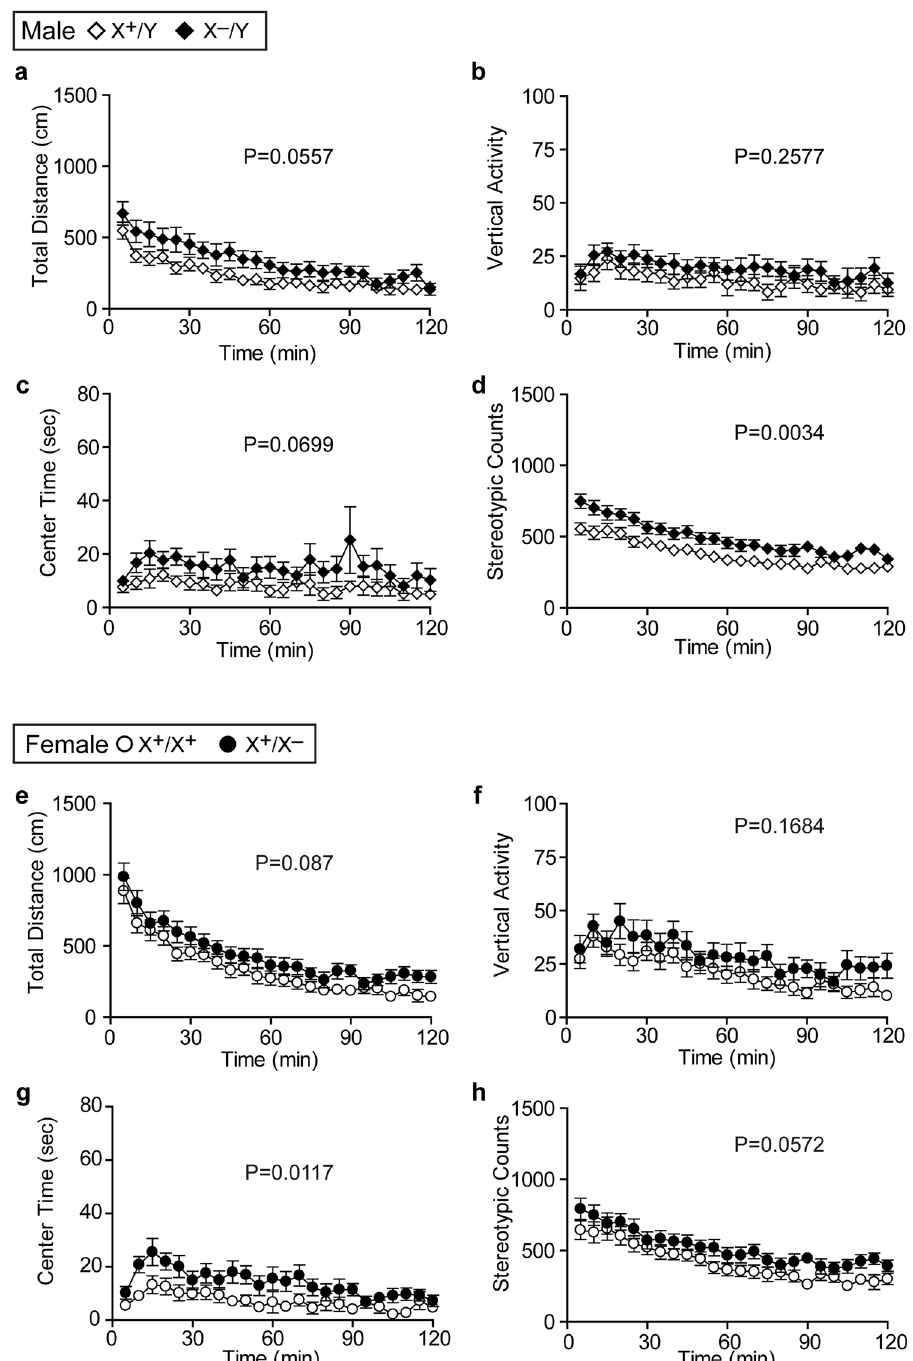
Figure 6. Increased activity of Pcdh19 mutant mice in the second open field test. ( a – d ) Test with male mice. ( e – h ) Test with female mice. Total distance ( a , e ), vertical activity ( b , f ), time spent in the center of box ( c , g ), and count of stereotypic activity ( d , h ) were measured. Pcdh19 hemizygous males showed significantly increased stereotypic counts, whereas Pcdh19 heterozygous females showed significantly increased time spent in the center of the box compared to wild-type